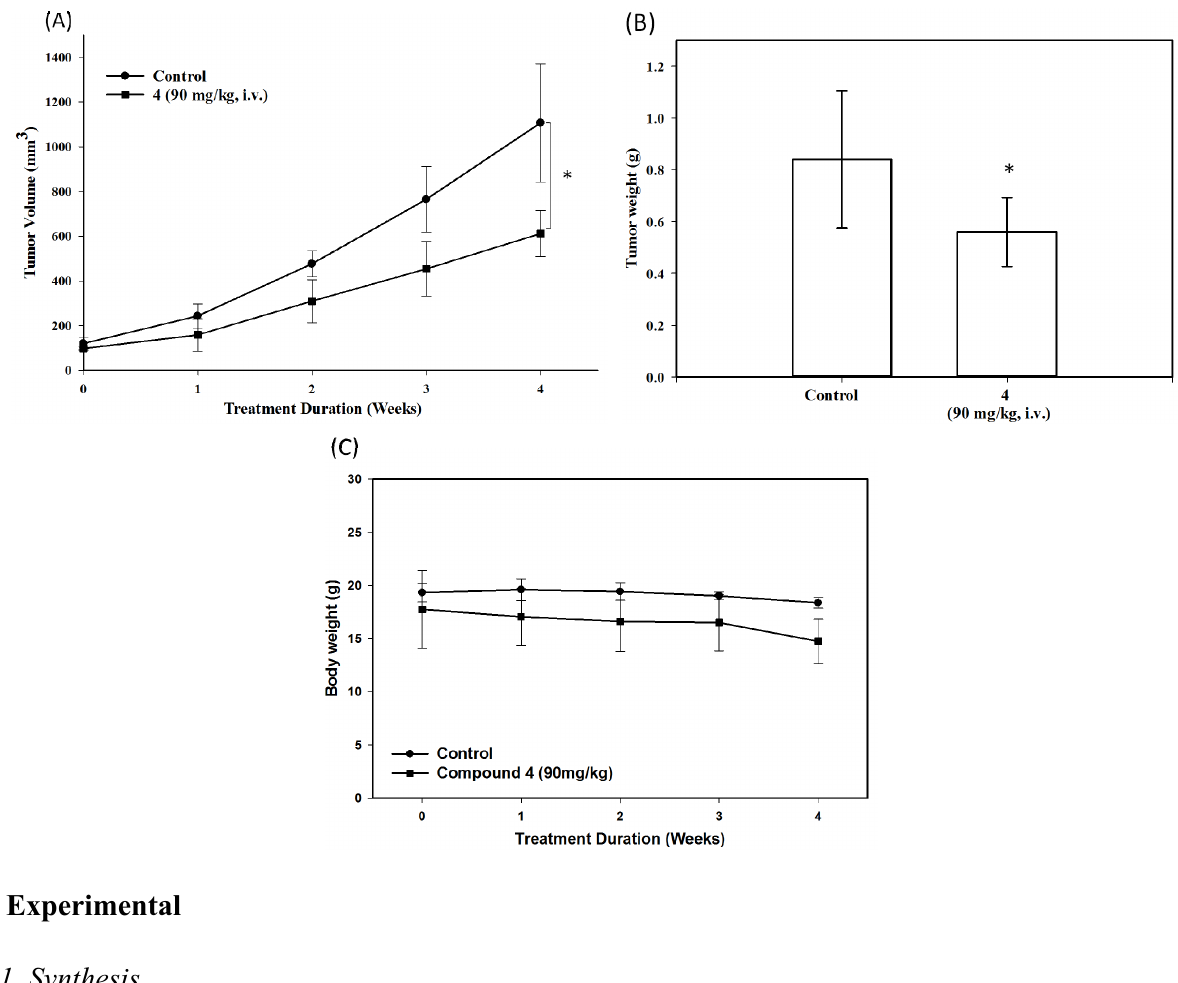
Figure 5. ( A ) Mean tumor volume-time profiles ( B ) Mean tumor weight-time profiles ( C ) Mean body weight-time profiles in MCF-7 xenograft nude mice ( n = 4) following i.v. dosing of 4 at 90 mg/kg 5 days per week for 4 consecutive weeks. * p < 0.05 vs.